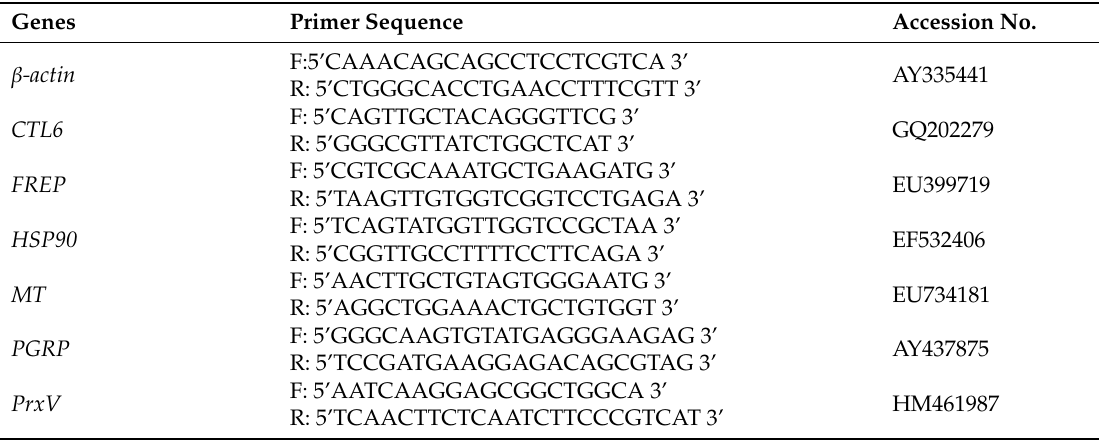
Table 1. Primers used for the analysis of mRNA expression via qRT-PCR